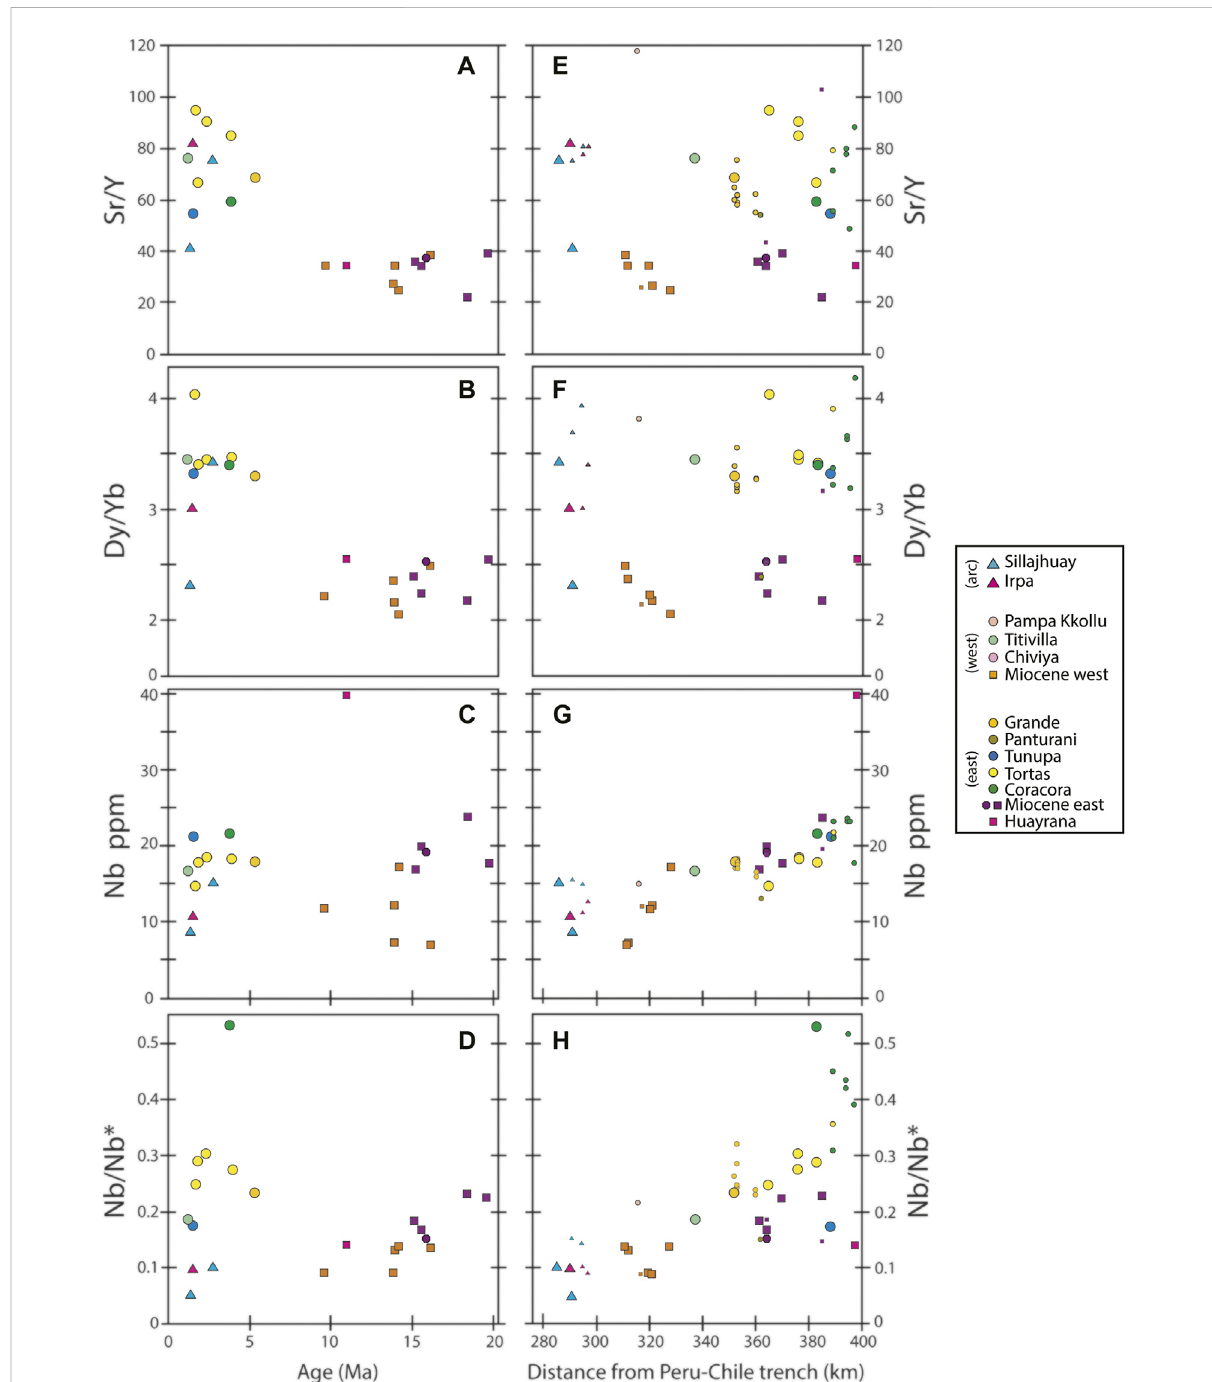
FIGURE 10 Geochemicaldatafrom theIntersalarRangeplottedagainstage (A – D) anddistancefromthePeru-Chiletrench (E – H) . Largersymbolsindicate samples with 49 Ar/ 39 Ar age control. Nb exhibits the best correlation with distance for all elements analyzed. Nb/Nb* is a measure of the depth of the negative Nb anomaly compared to U and K. See text for